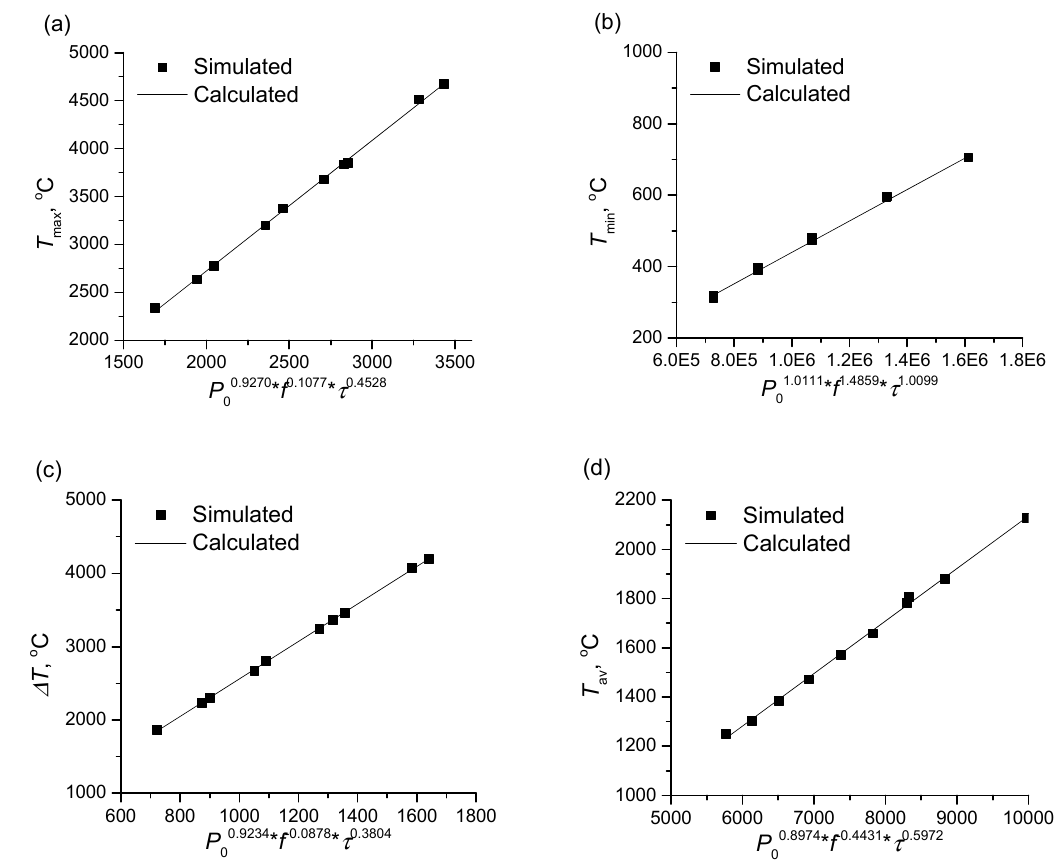
Figure 10. Comparisons between the simulated and the calculated results: ( a ) T max , ( b ) T min , ( c ) ∆ T and ( d ) T av .